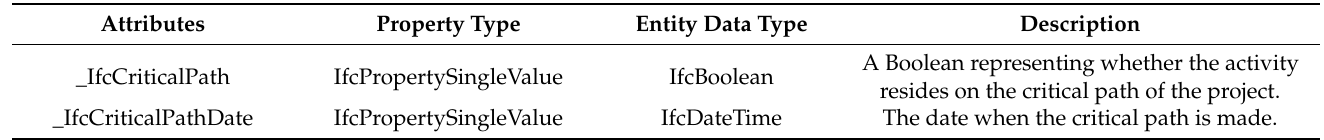
Table 5. Definition of the Pset_CriticalPath.